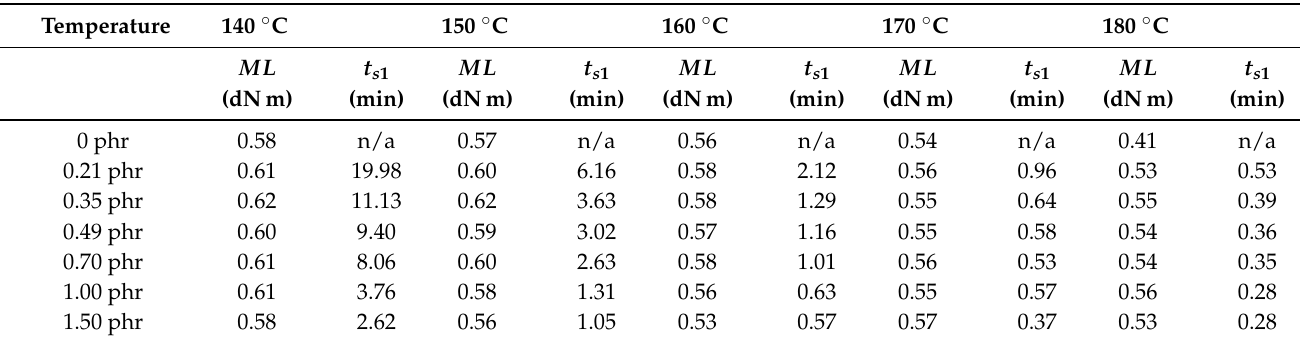
Table 1. Curing parameters for silicone rubber compounds concerning minimum torque ( ML ) and induction or scorch time ( t s 1 ) for different crosslinking temperatures and varied dicumylperoxide concentrations.